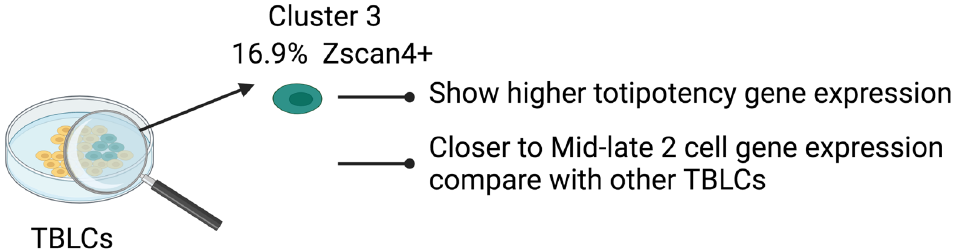
Figure 10. Summary image showing features of cluster 3 TBLCs. Supplementary Materials: The following are available online at www.mdpi.com/xxx/s1. Figure S1: Single-cell RNA sequencing analyses of TBLCs and ESCs. Figure S2: Additional totipotency gene 10.3390/cells10113111/s1. Figure S1: Single-cell RNA sequencing analyses of TBLCs and ESCs. and pluripotency gene expression patterns of the TBLCs clusters, ESCs, early embryo cells, and Figure S2: Additional totipotency gene and pluripotency gene expression patterns of the TBLCs 2CLCs. clusters, ESCs, early embryo cells, and